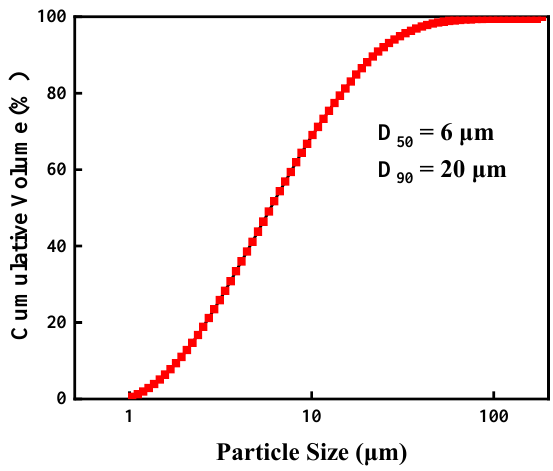
Figure 1. Particle size distribution of kaolinite samples.